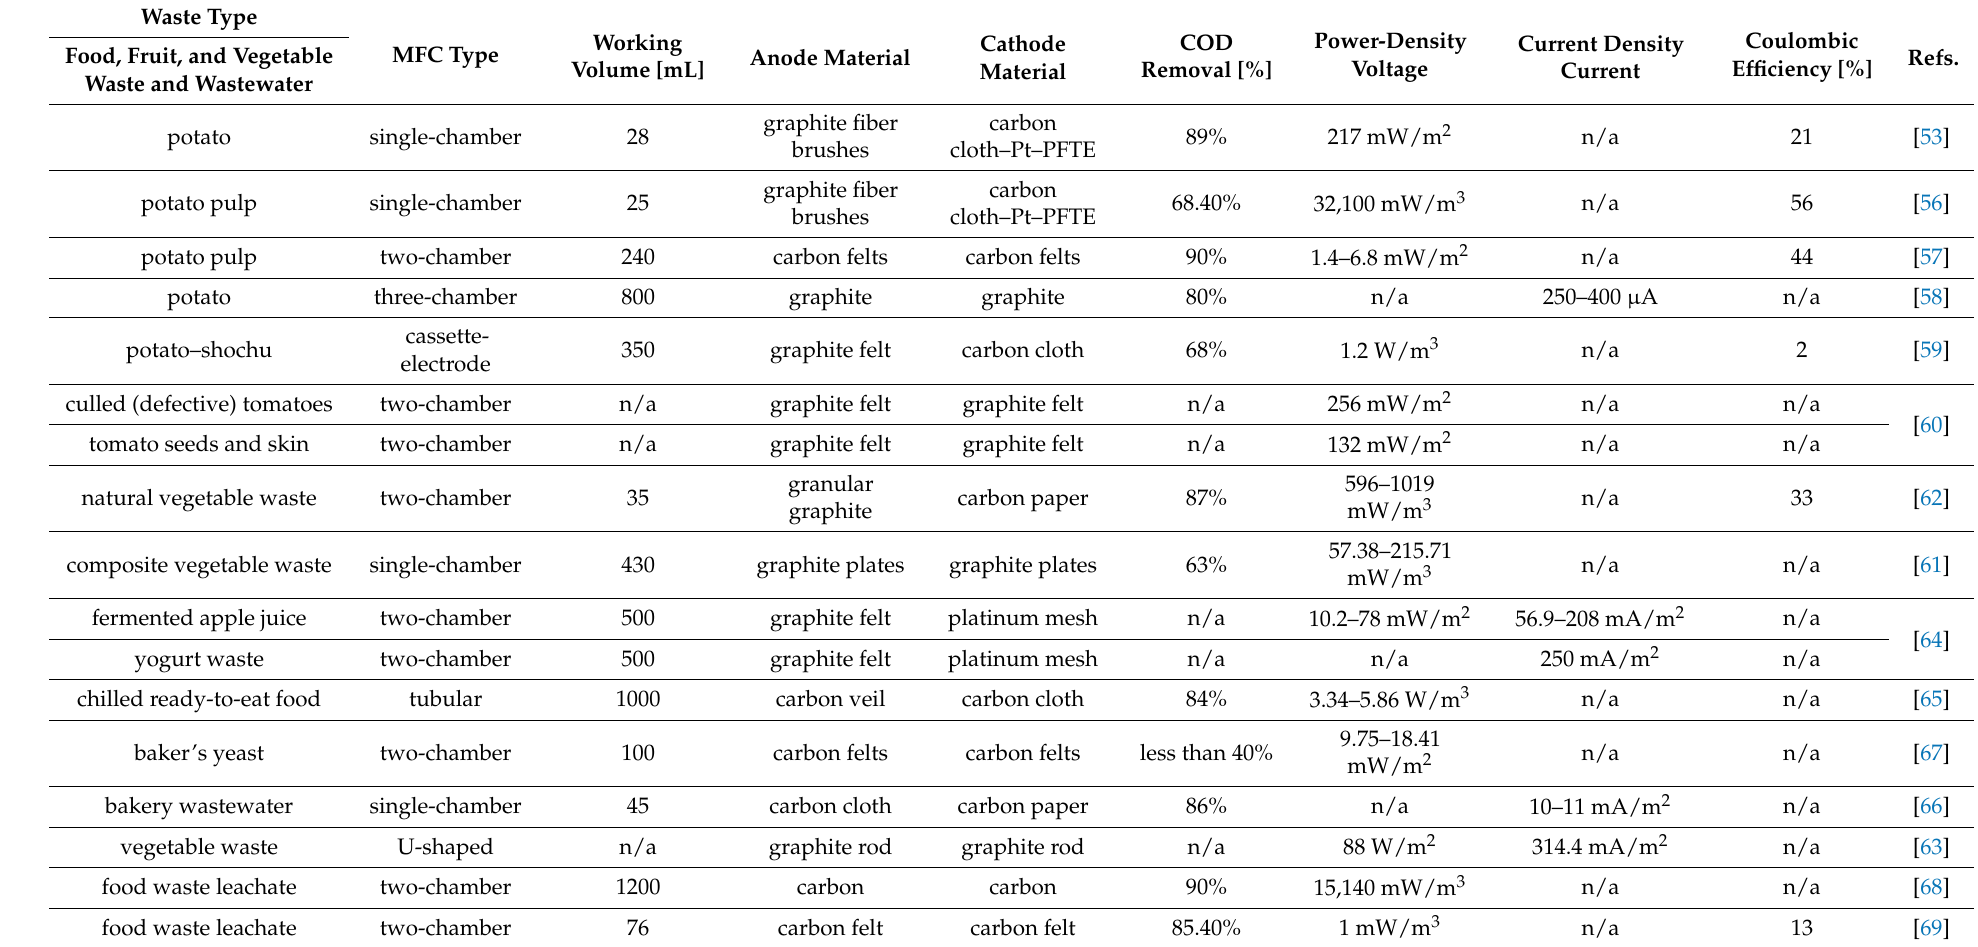
Table A1. Summary of studies reporting use of food, fruit, and vegetable waste and wastewater in